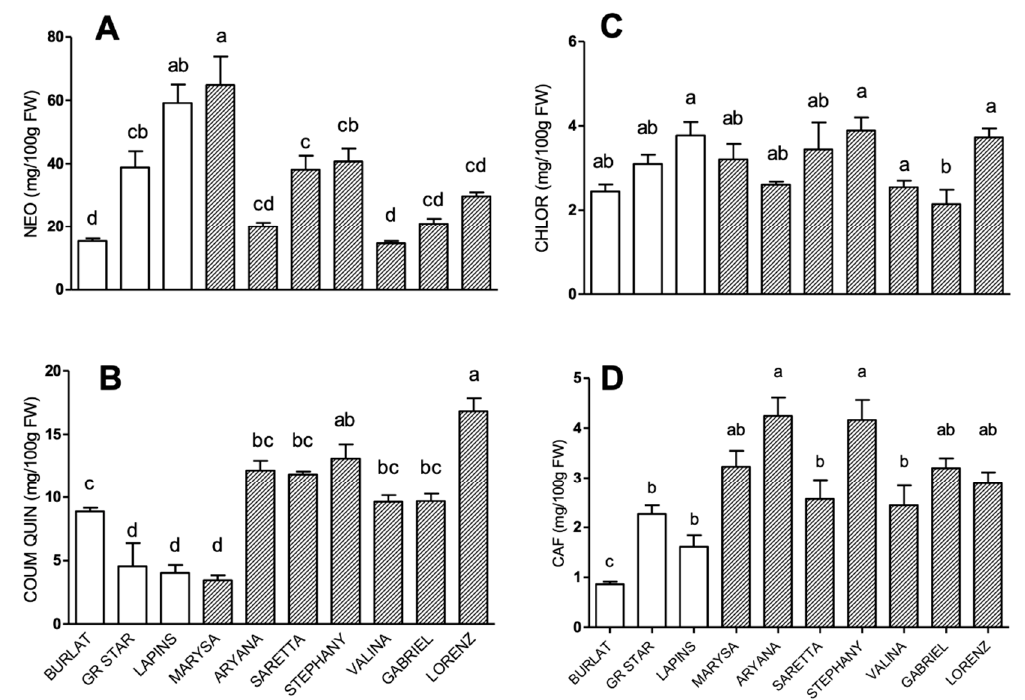
Figure 2. Phenolic acid levels (mg/100 g FW) in sweet cherry cultivars: ( A ) neochlorogenic acid, ( B ) coumaroylquinic acid, ( C ) chlorogenic acid, and ( D ) caffeic acid. Data are the mean ± SEM of four biological replicates. Different letters indicate statistical significance ( p < 0.05).